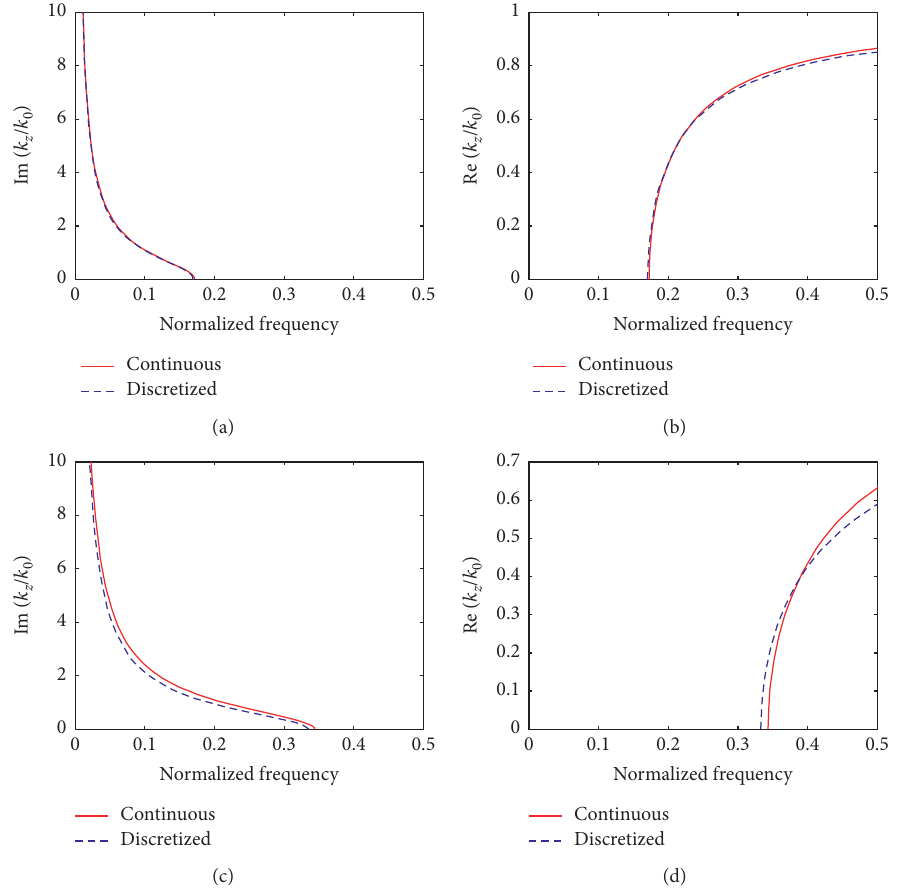
k in the continuous and discretized cases at two different wavenumber points: ( k x , k y ) � (20, 20) z / 0